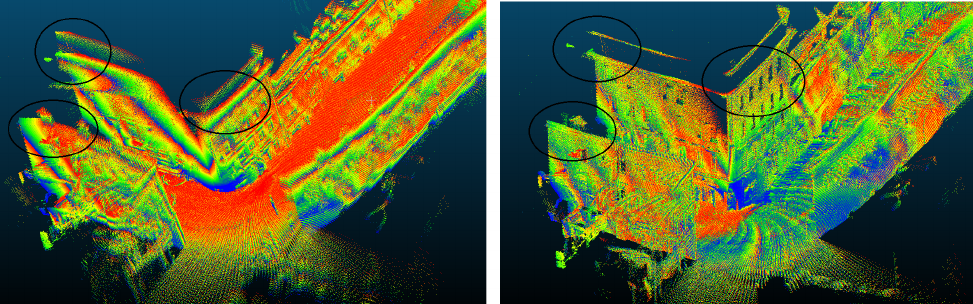
Figure 11: Real point cloud #3: left, before optimization of the parameters; right, after optimization. The two images have the same point of view.